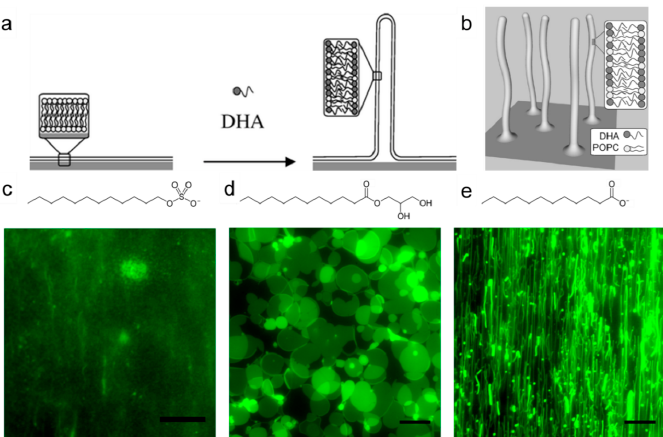
Figure 2. ( a ) Treatment of supported lipid bilayers with docosahexaenoic acid (DHA) induces three-dimensional membrane morphological changes; ( b ) Schematic of DHA-induced, elongated lipid structures on top of supported lipid bilayer. Top-down view of changes in the morphology of supported lipid bilayers, including ( c ) membrane solubilization (SDS treatment); ( d ) membrane budding (GML treatment); and ( e ) membrane fibrillation (LA treatment). The scale bars in all micrographs are 20 μ m. Reproduced with permission from Refs. [46,47].